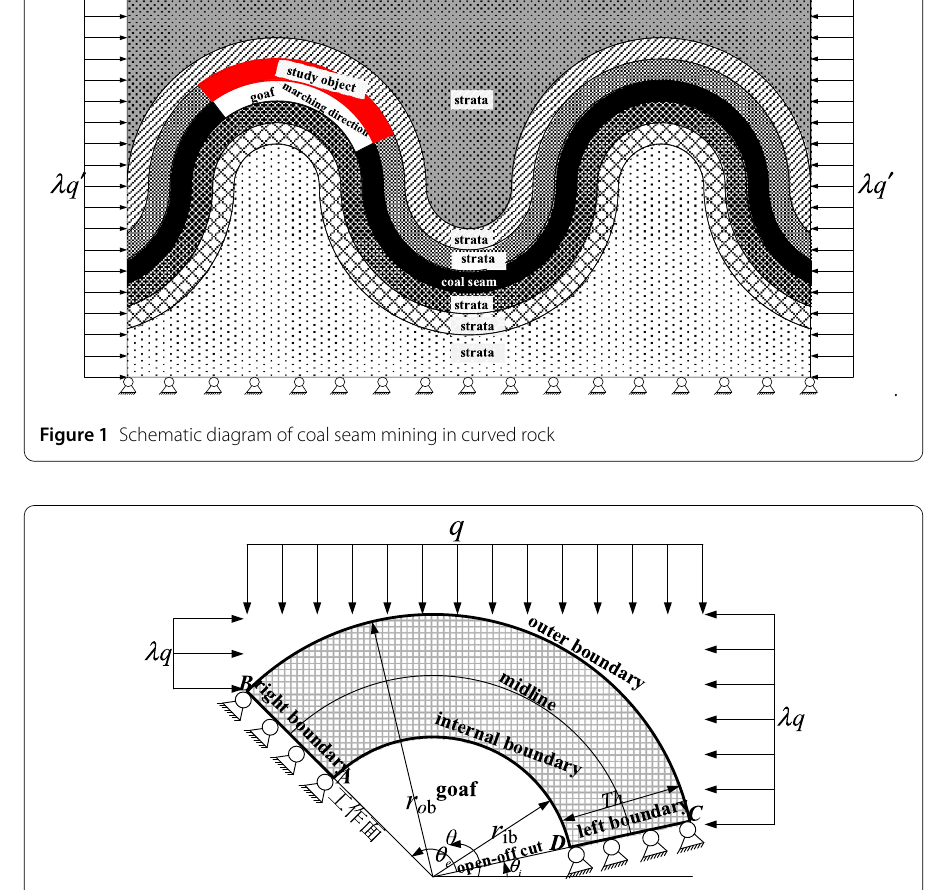
Figure 2 Numerical calculation model of curved